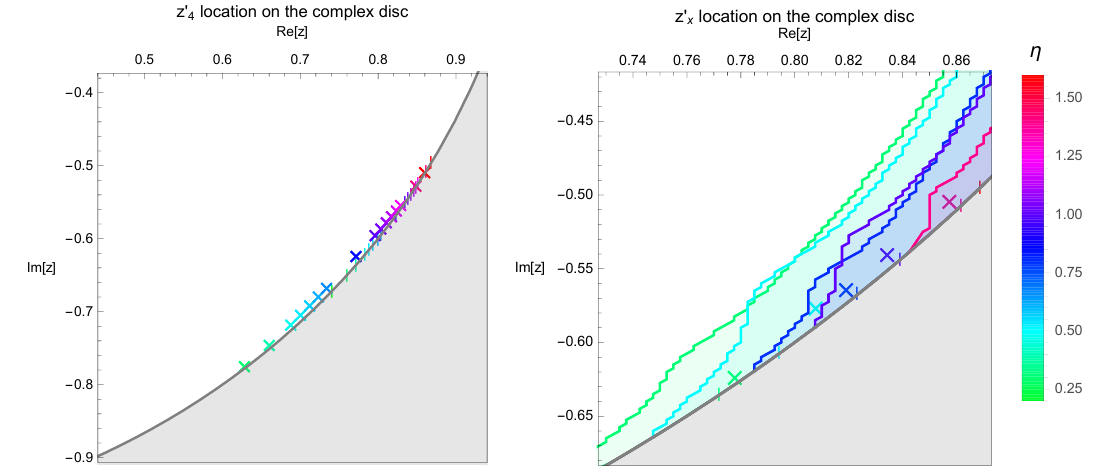
Figure 15. The location of the complex resonance zeros (colored crosses) z 0 for η ranging between 0 and 1 . 6 (indicated by the color). The white region is part of the unit z -disc. Colored vertical stubs indicate the locations of the inelastic threshold. For z 0 relevant non-exclusion regions in the same colors (these are the same as the blue regions of figure 10, zoomed-in near z 0 ). In particular, z 0 lies in the same connected component of the non-exclusion x x region as the inelastic arc, and consequently its existence cannot be rigorously